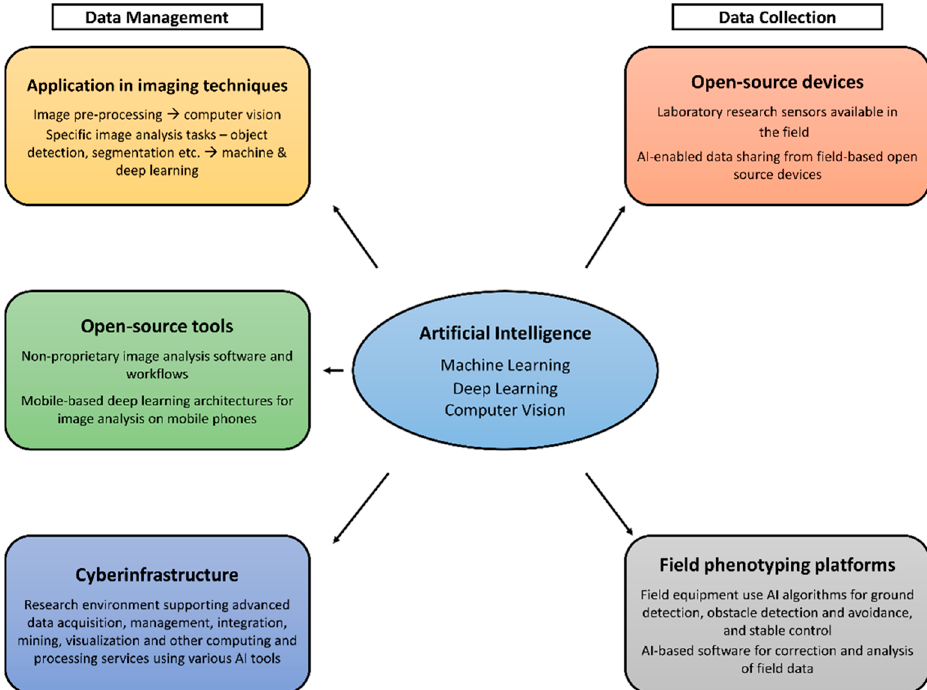
Figure 1. Workflow illustrating application of AI in phenomics.